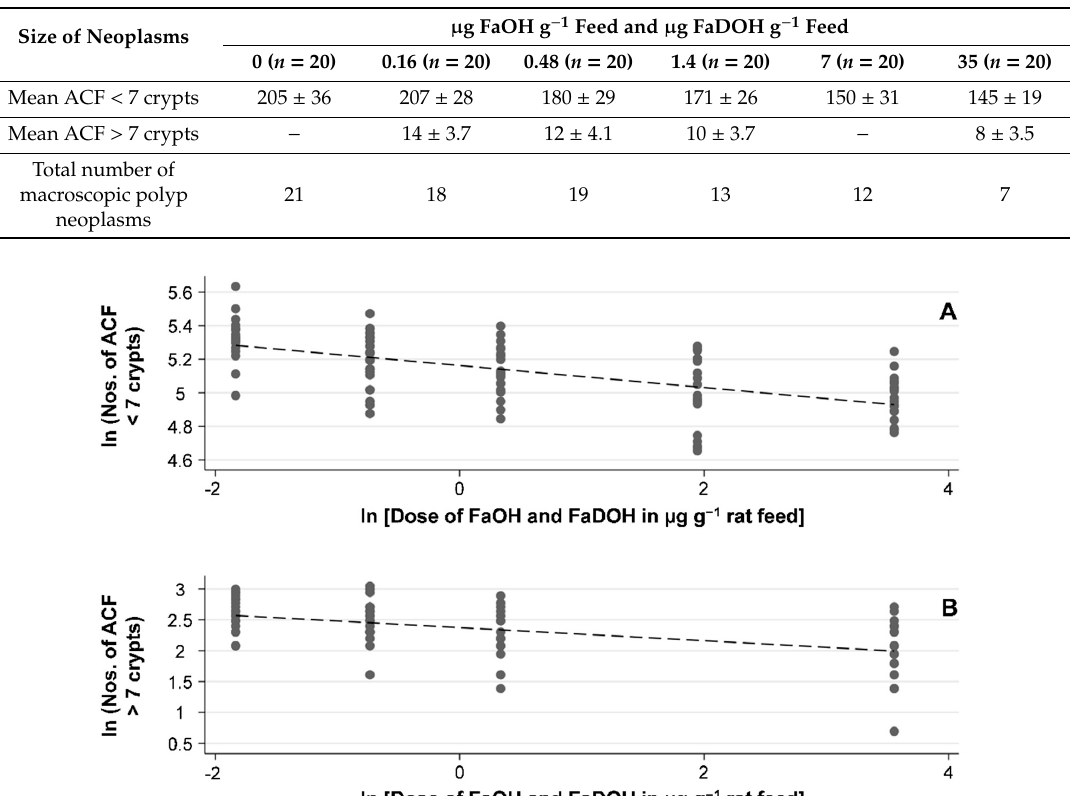
Figure 3. FaOH and FaDOH in the diet of AOM-challenged rats show a significant